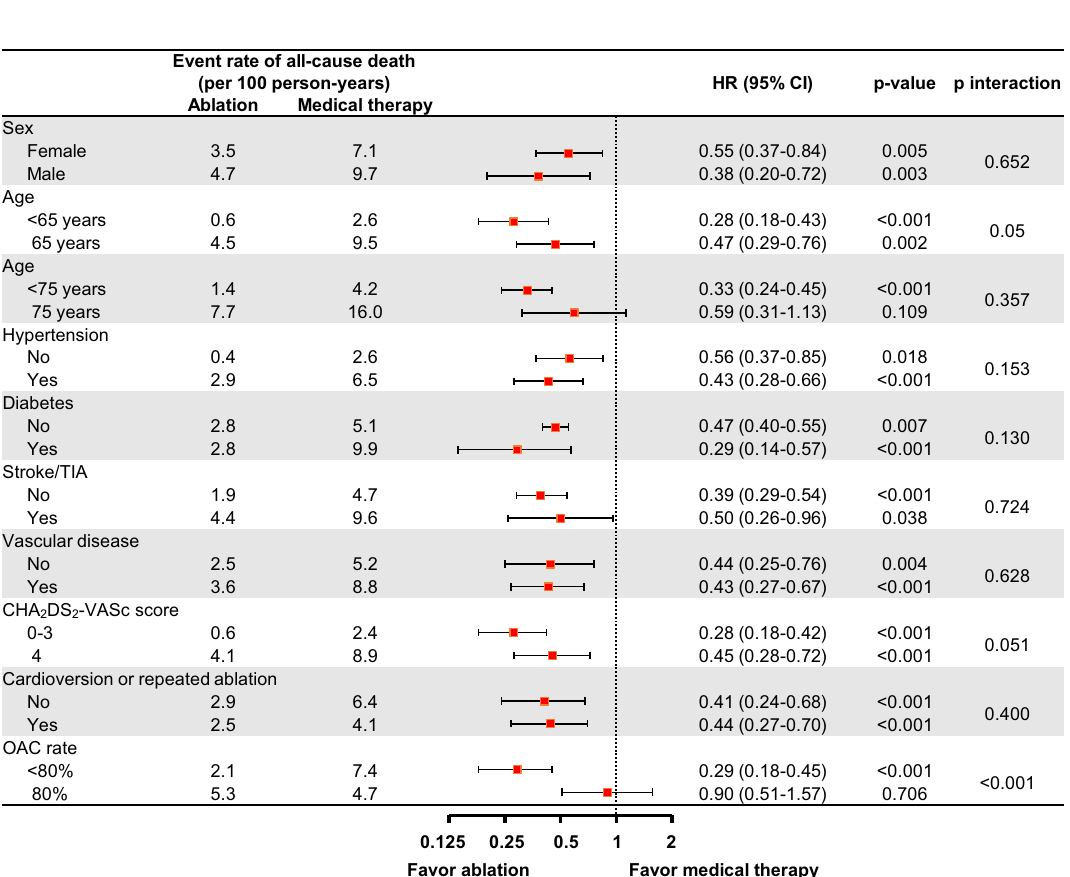
Figure 3. Subgroup analyses of the risk of all-cause death. HR: hazard ratio, TIA: transient ischemic attack, OAC: oral